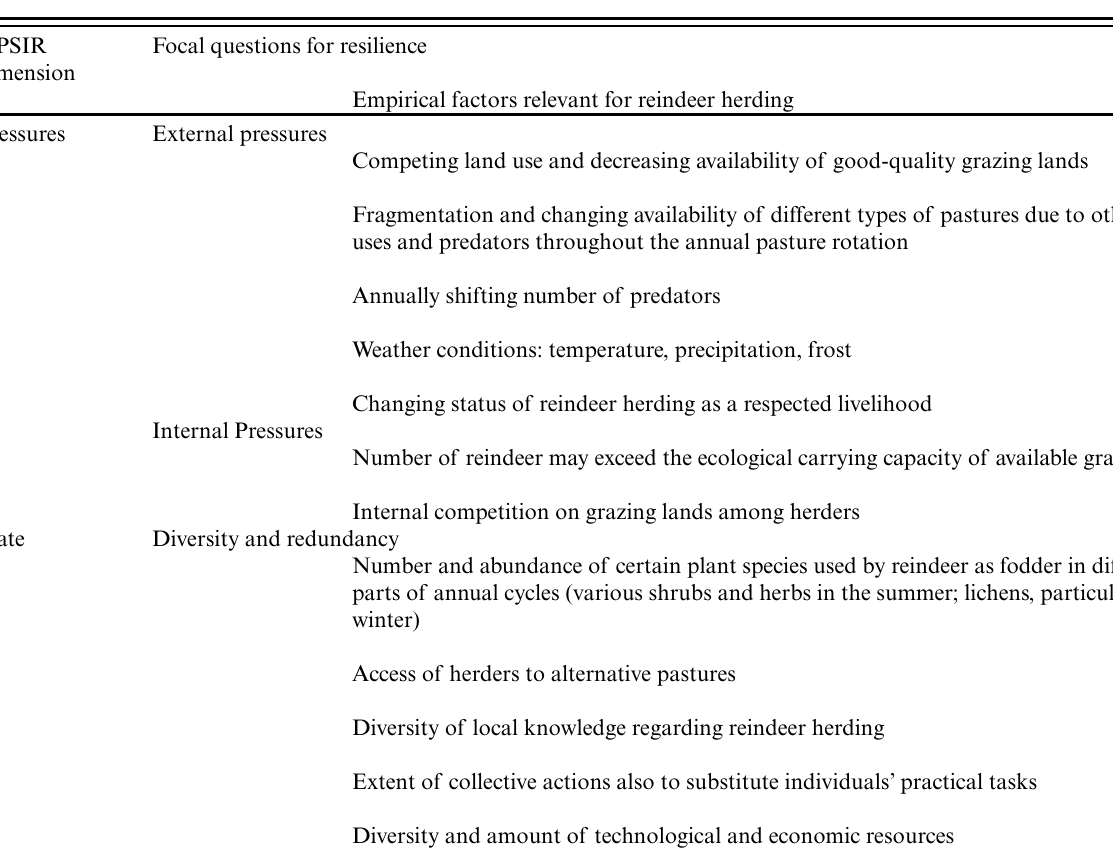
Table 3 . Key DPSIR factors for reindeer herding in